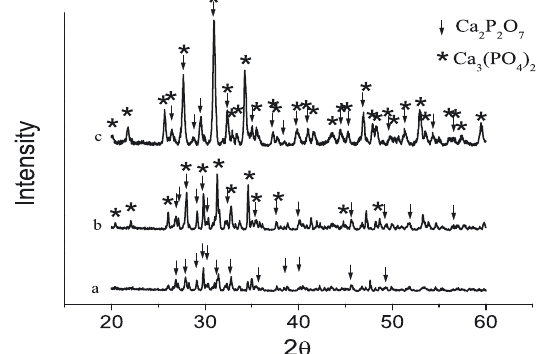
Figure 5. XRD for the samples from powders synthesized from (NH